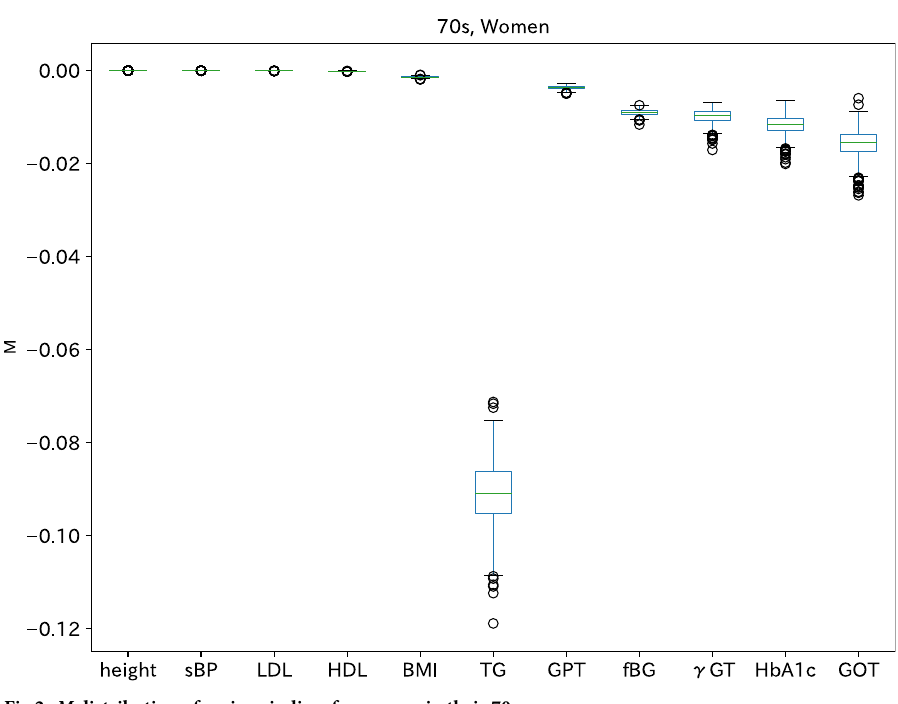
Table 3. Frequencies of orders of various indices in 1000 trials for women in their 70s.